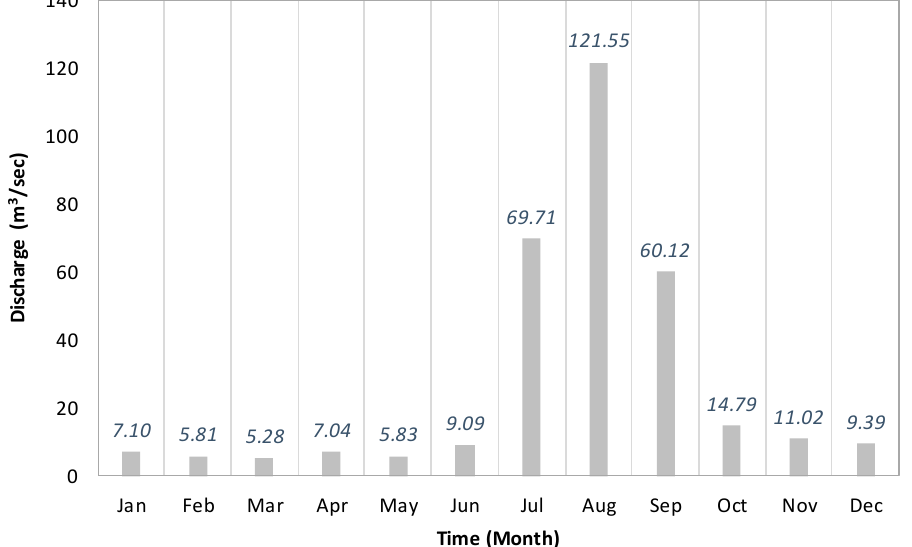
Figure 6. Annual monthly average flow at the Kesem Arerti station from 2006 to 2015.